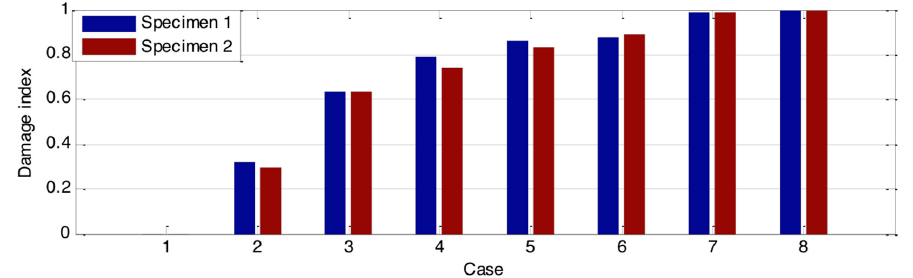
Figure 7. Damage indices of timber with different crack depths.